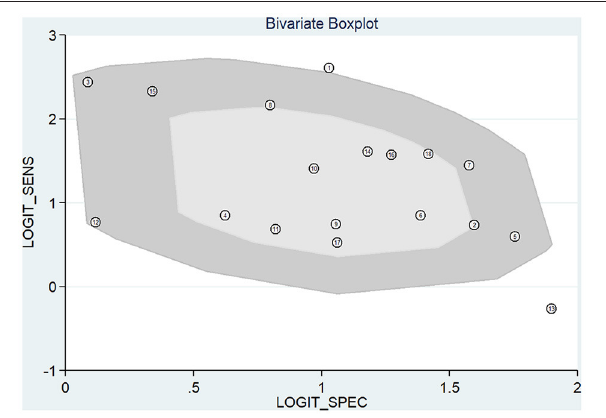
FIGURE 5 | Deeks’ funnel plot evaluating the potential publication bias.